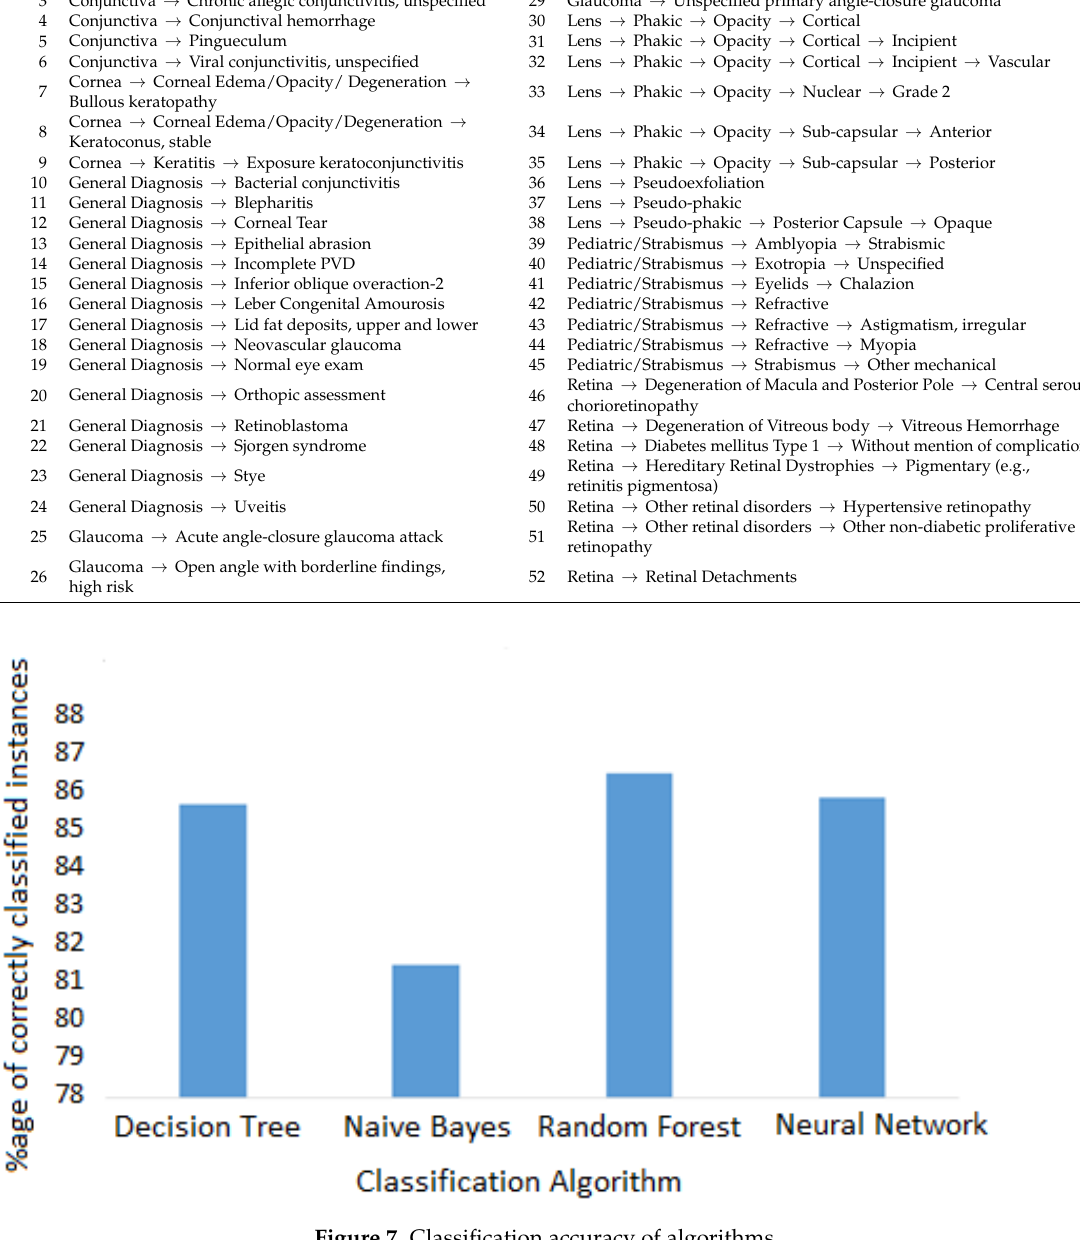
Figure 7. Classification accuracy of